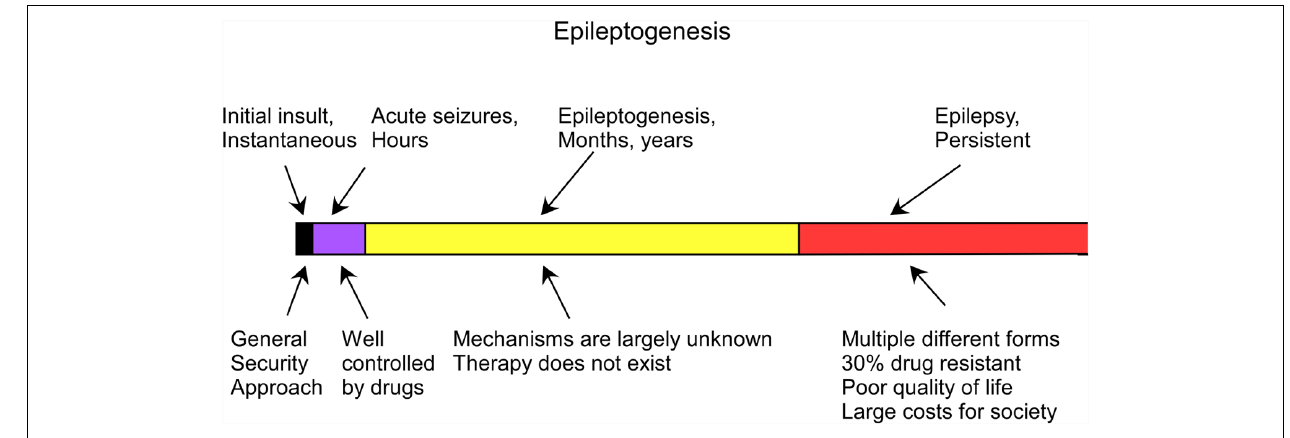
FIGURE 1 |Time course of the development of epilepsy from brain trauma (adapted fromTimofeev,